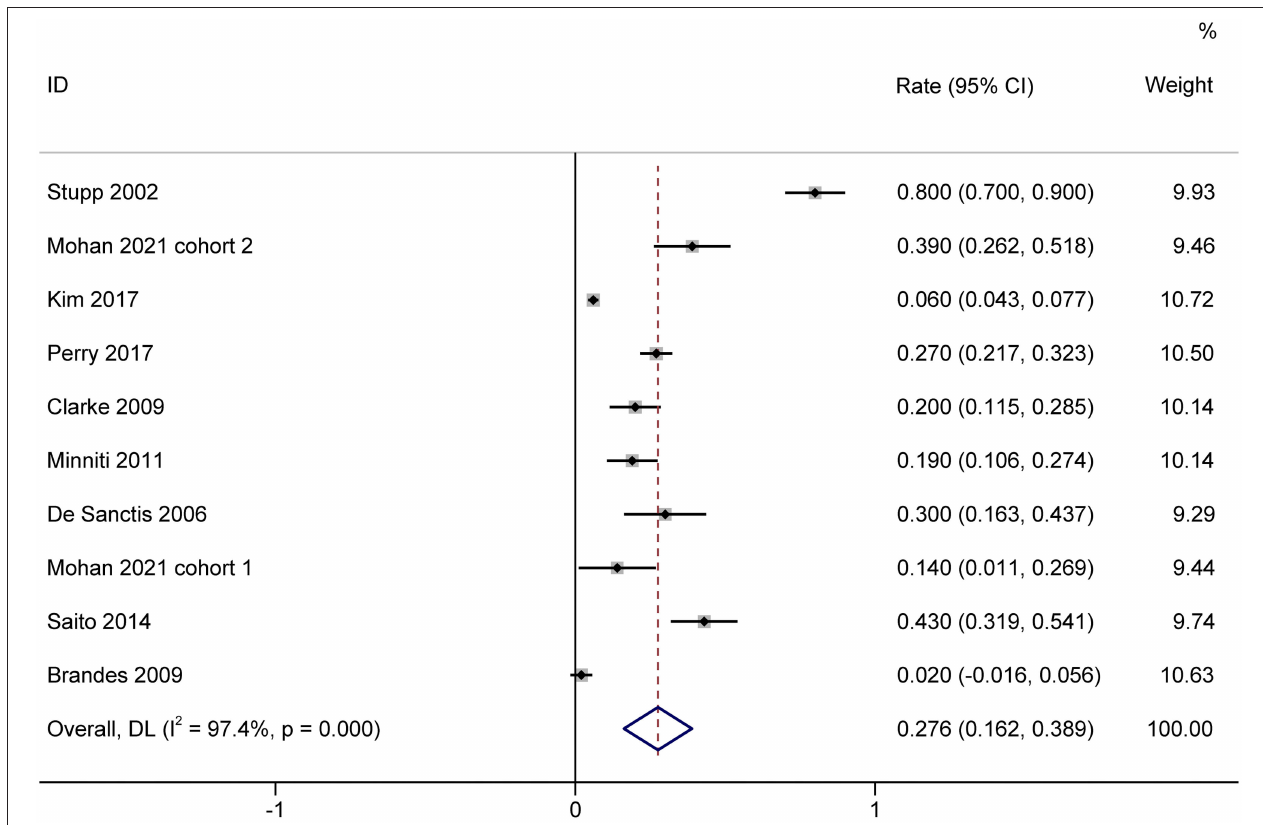
FIGURE 4 | Forest plots of the incidence rate of severe lymphopenia and 95% CIs in GBM glioma patients. HR, hazard ratio; CI, confidence Interval; GBM, Glioblastoma. Weights are from random-effects model.